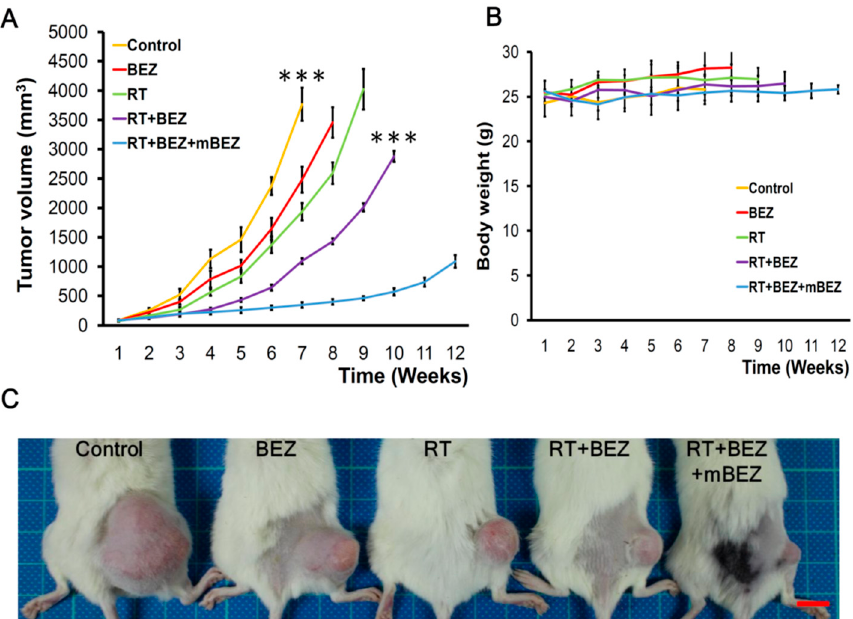
Figure 5. BEZ235 maintenance treatment following RT + BEZ235 treatment significantly inhibited CRC xenograft tumor growth. ( A ) Maintenance BEZ235 following RT + BEZ235 treatment significantly suppressed xenograft tumor growth when compared with other treatment groups, especially RT + BEZ235 treatment without BEZ235 maintenance. The results of the tumor volume are expressed for n = 6 in each treatment group. *** p < 0.001 compared with the control group; *** p < 0.001 compared with the RT + BEZ235 group. ( B ) The body weight of mice in the five groups did not di ff er, and no marked changes were observed during the treatment period. ( C ) Representative pictures of each treatment group. Mice were photographed during the seventh week after treatment. Scale bar: 10